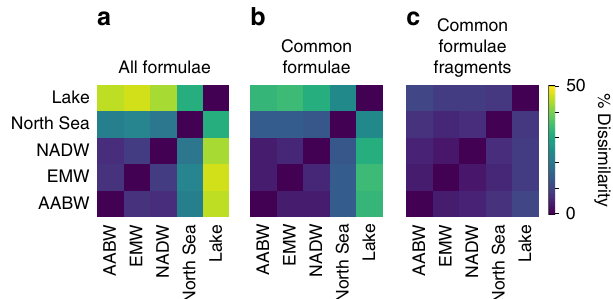
Fig. 3 Molecular dissimilarity of DOM from different environments on different compositional levels. Bray – Curtis dissimilarity based on relative FT-ICR-MS signal intensities of a all detected, unfragmented molecular formulae in full range mass spectra ( n = 6166) and b common molecular based on relative FT-ICR-MS signal intensities of fragments ( n = 324) of the most intense common molecular formulae ( n = 54) that were selected for fragmentation experiments. AABW Antarctic Bottom Water,